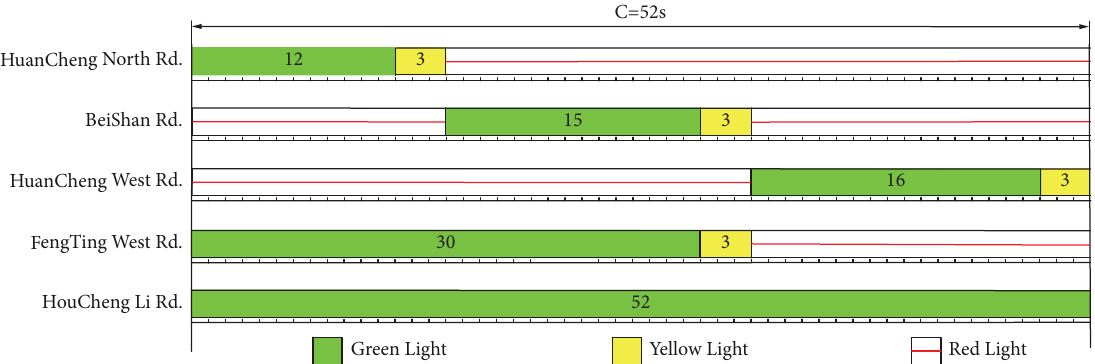
Figure 6: Optimized signal timing in cycle 2 for the model output scheme.